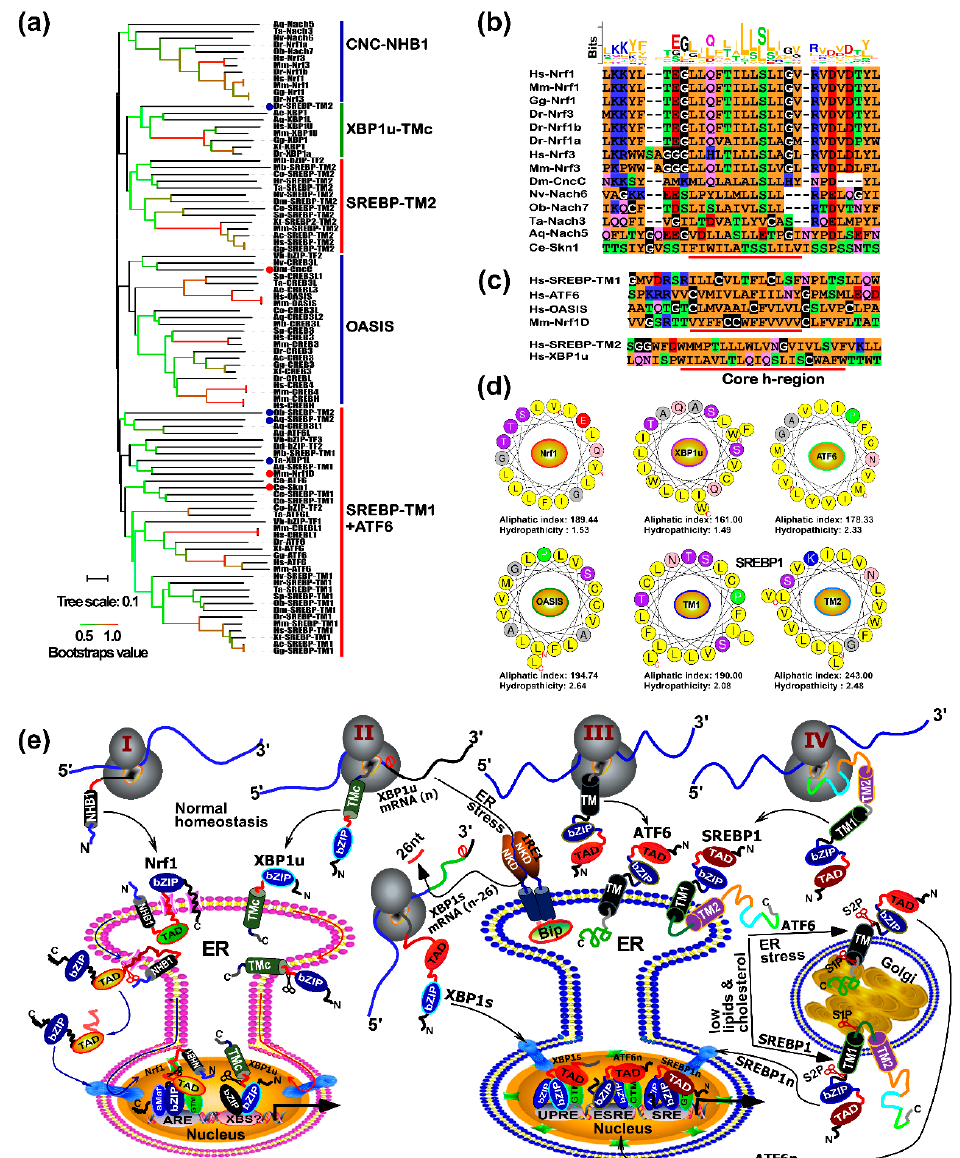
Figure 3. Classification of the current known TM-containing transcription factors. ( a ) All the putative TM-containing domains within bZIP and SREBP proteins were subjected to construction of the neighbor-joining phylogenetic tree by the MEGA 6.0 analysis with 1000 bootstrap replicates; Respectively, the red and blue dots represent CNC-NHB1 and others which of clustering is not gregarious. ( b ) A multiple sequence alignment, with a color Logo of those NHB1-associated TM regions within related Nach/CNC-bZIP proteins, was carried out by using the DNAMAN8.0 and MEME tools. ( c ) Shows two similar sequence alignments of additional TM domains of ATF6, OASIS, Nrf1D and XBP1u with SREBP1-TM1 and -TM2, of which the hydrophobic h-region cores are underlined. ( d ) Six wheels of a-helixes are folded by the NHB1-associated TM1 of Nrf1, the C-terminal TM region of XBP1u, the central TM domains of ATF6 and OASIS, as well as SREBP1-TM1 and -TM2, respectively. Both aliphatic index and hydropathicity were also calculated. ( e ) Four distinct membrane-topobiology models are proposed to give a clear explanation of these TM-containing transcription factors. With distinct catalogues of dynamic topological folding within and around the ER and/or Golgi apparatus, before being translocated out of membranes in order to be released and transferred into the nucleus, prior to activating different sets of cognate target genes, under normal homeostatic or the ER-derived stress conditions.